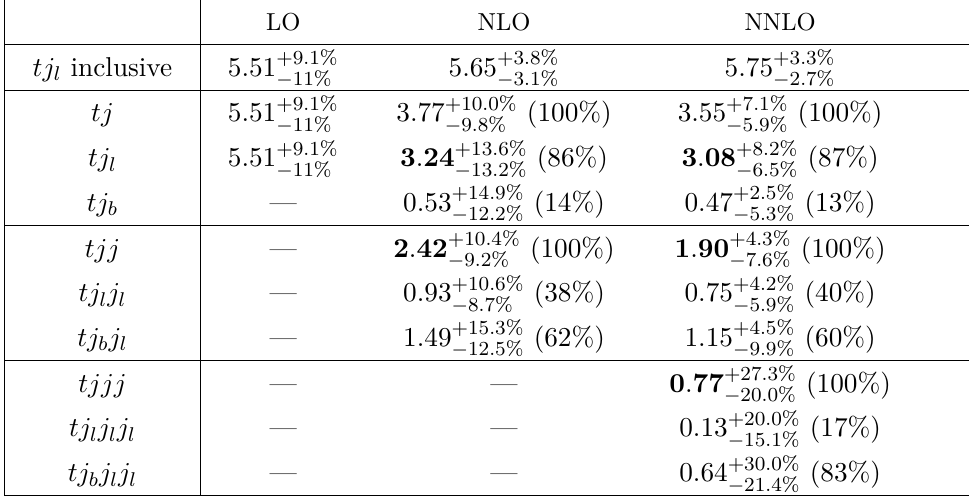
Table 9 . Cross sections for the production of a top quark ( W plus p T -leading b -jet) and additional jets using DDIS scales, in pb. The cross sections are given in the fiducial region as in table 8, but apart from the inclusive tj l row the jet requirements are adjusted accordingly. j b denotes a b -tagged jet and j l a light-quark jet (not b tagged). Contributions with more than one additional b -tagged jet are negligible and omitted. Uncertainties from a six point scale variation are given in super- and subscript. Percentages in parenthesis give the fraction with respect to the individual inclusive jet category. Numbers in bold font in each column add up to the tj l inclusive result within numerical